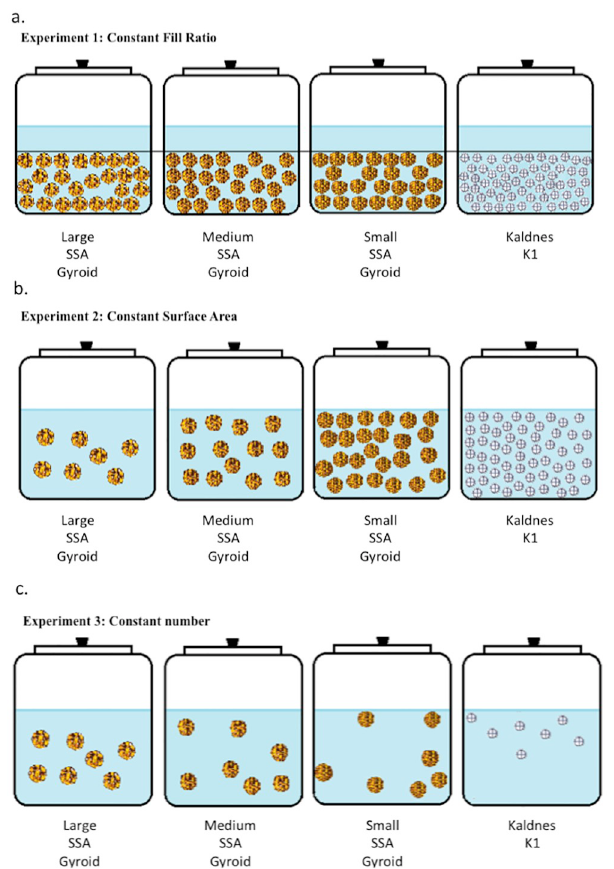
Fig 3. Schematic of the experimental design for the three experiments. (a) Experiment 1, testing constant biocarrier fill ratio; (b) Experiment 2, testing constant total biocarrier surface area; (c) Experiment 3, testing constant number of biocarriers. Diagram not to